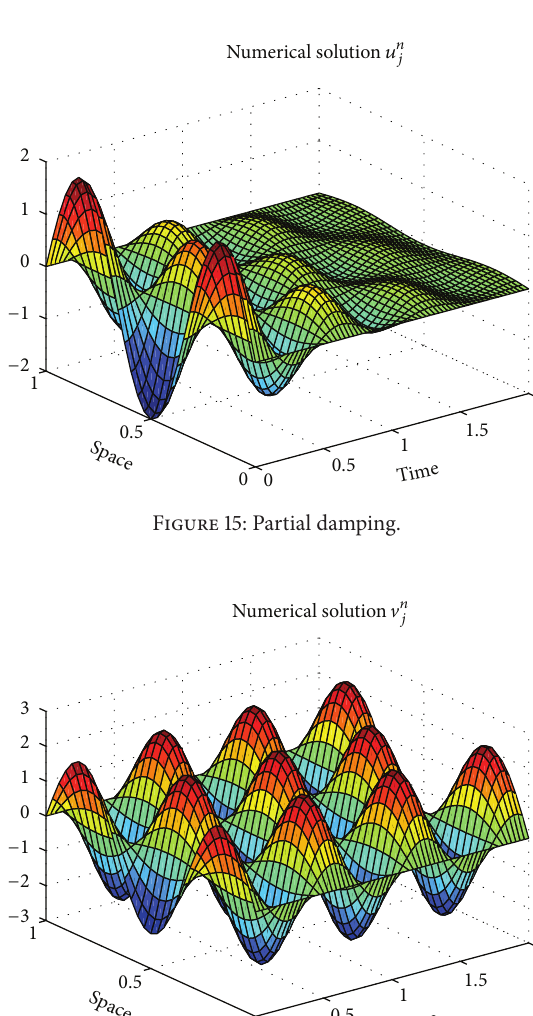
Figure 12: Δ𝑡/Δ𝑥 = 0.960 .